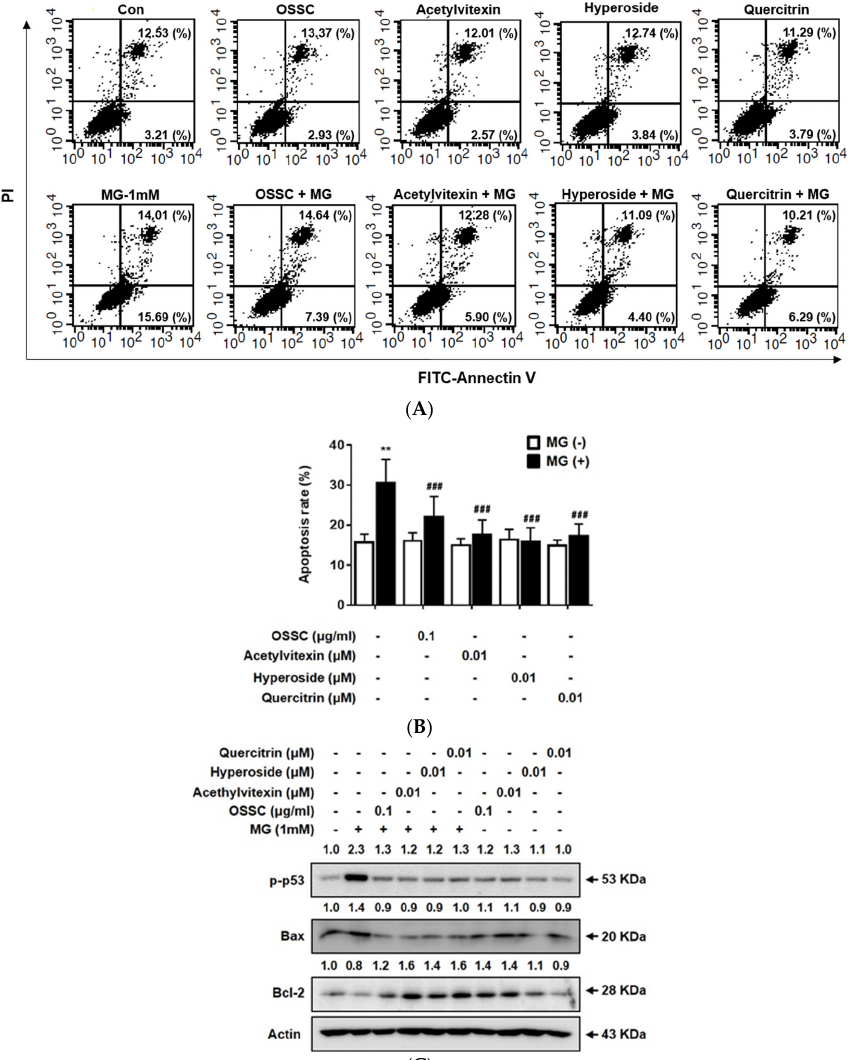
Figure 2. Effects of the OSSC extract and its maker compounds on MG-induced apoptosis. ( A ) Annexin V and PI staining; ( B ) percent rate of apoptosis. Data are expressed as the mean ± S.E.M. ( n = 3). ** P < 0.01 vs. control; ### P < 0.001 vs. MG; ( C ) expression of apoptosis-related proteins (p-p53,